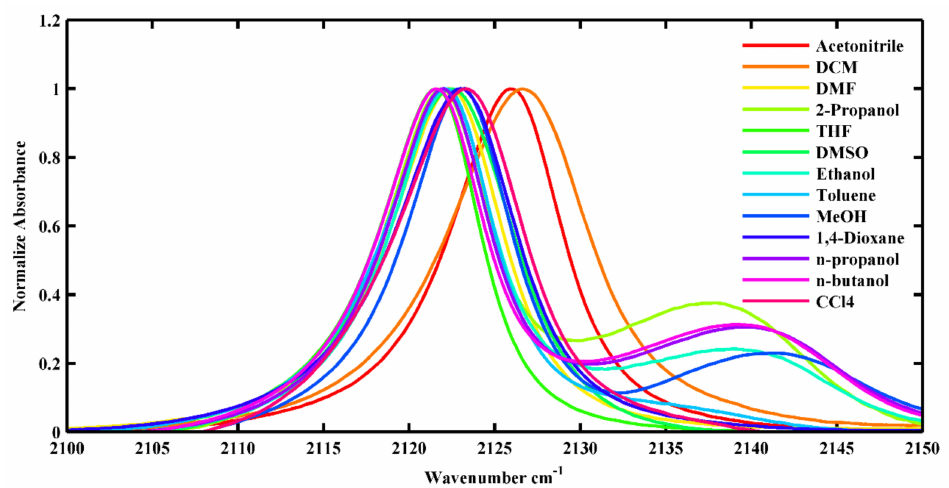
Figure 2. The NC stretching vibration of 5ICI in the studied solvents. Table 1. The lower frequency peak ( ω 0 ) and relatively weaker blue-shifted peak ( ω 1 ) of the isonitrile group (NC) stretching mode in various solvents. Also listed for each solvent are its